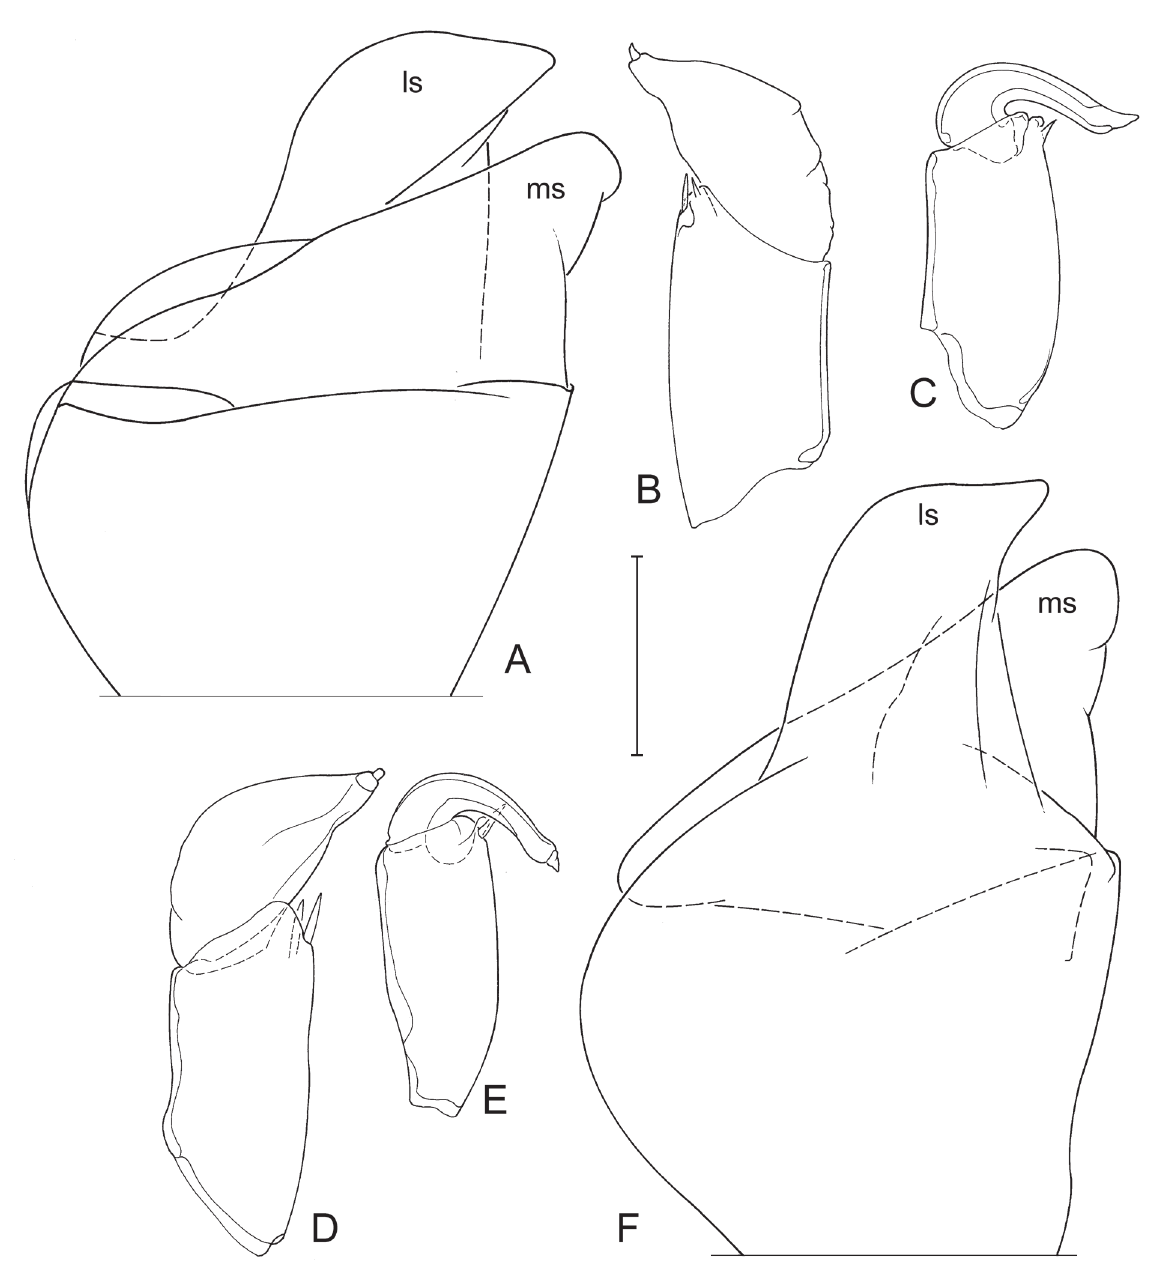
Fig. 8. Bennelongia timmsi sp. nov., male type specimens from type locality (Wave rock, BVt/10/05). — A-C . Paratype M (Oc.3312): A . Hemipenis (both hemipenes symmetrical in this specimen). B . right prehensile palp. C . left prehensile palp. — D-F . Holotype ♂ (WAMC52228): D . right prehensile palp. E . left prehensile palp. F . Hemipenis (both hemipenes symmetrical in this specimen). scale: a-F = 92